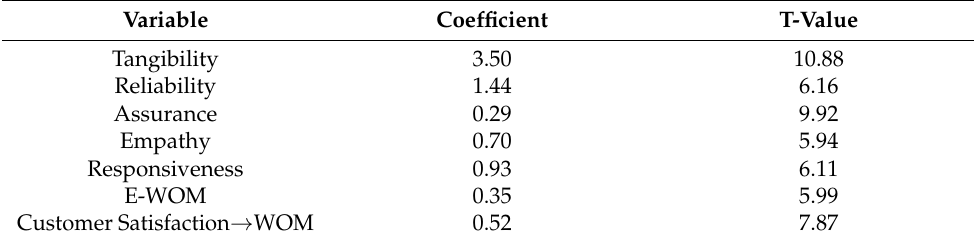
Table 5. The impact of